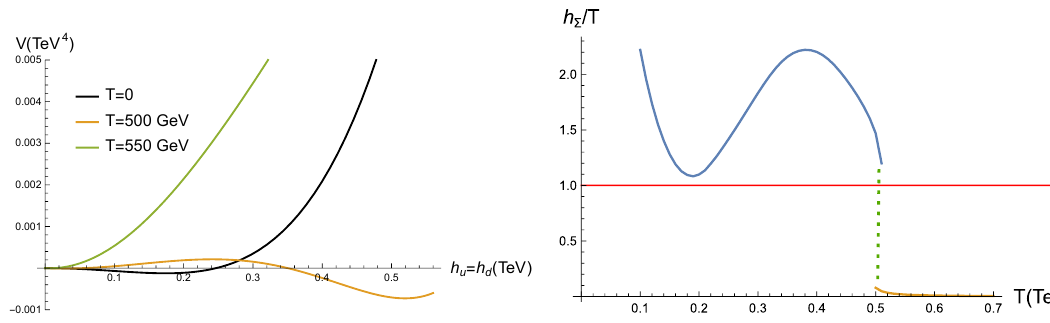
Figure 6 . Left panel: an example model in which the Higgs potential in the h u = h d direction has a single minimum at zero temperature (black), two minima at T = 500 GeV (orange), and a single minimum at T = 550 GeV (green). Right panel: the evolution of h Σ ( T ) in this model with two coexisting minima and a phase transition at T ' 500 GeV marked by the dotted line. For both panels we take n χ = n ψ = 10 , tan β = 1 , m H,H = 2 TeV , µ χ = 0 . 77 TeV, µ ψ = 1 . 5 TeV, + ,H A µ H = 150 GeV , Λ = 2 TeV, c χh = 3 . 7 , c χ = − 0 . 2 , c ψh = − 4 . 7 . We take the alignment limit in the Higgs sector and the MSSM superpartners to be above the scale Λ .